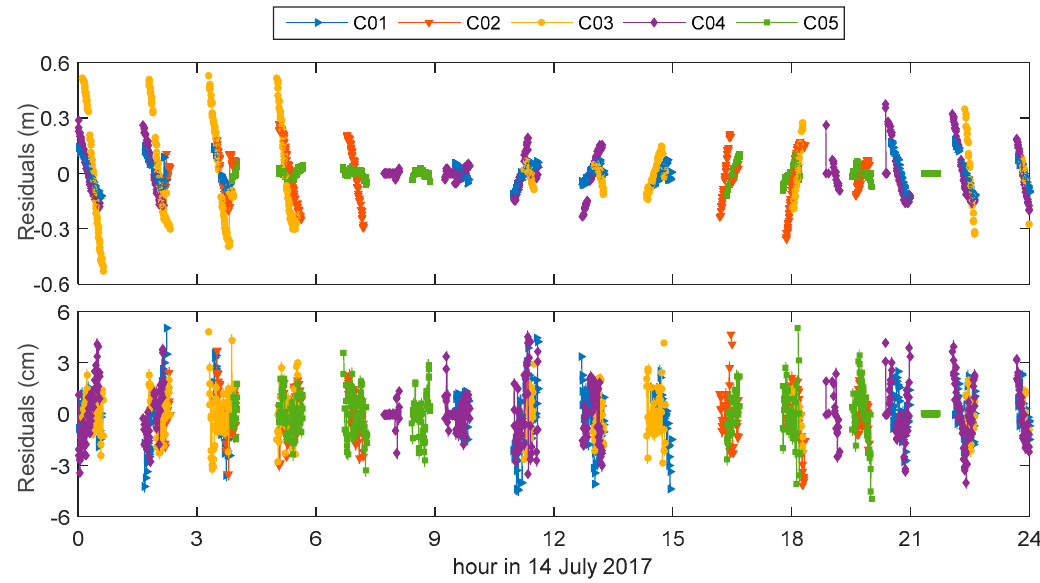
Figure 4. Phase observation residual series of five BeiDou GEO without ( top ) and with ( bottom ) calibrating orbit errors on 14 July 2017.